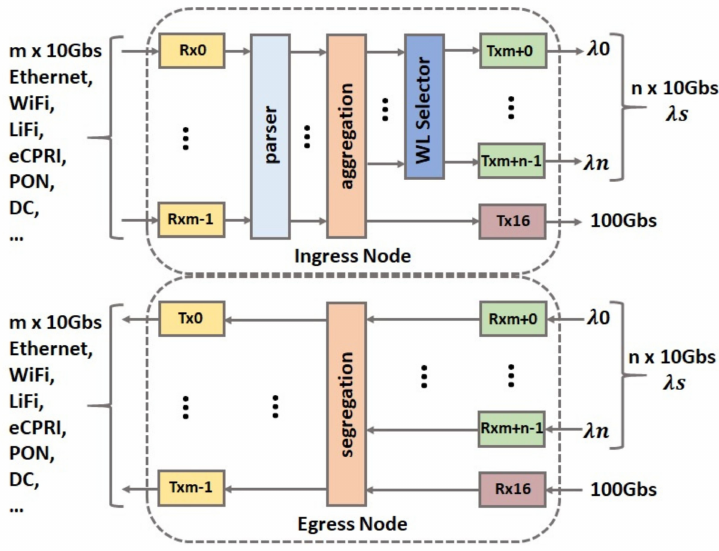
Figure 12. The TSON edge node current data plane architecture. m + n − 1 = number of 10 G input–outputs